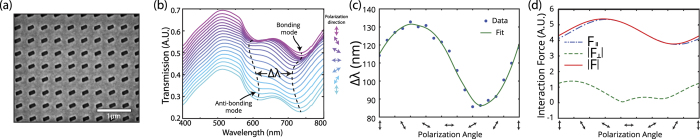
(a) A top-view scanning electron microscope image of the metasurface. (b) The transmission spectra associated with different linear polarization angles, where we observe the presence of bonding and anti-bonding modes. (c) Shift in the wavelengths of the bonding and anti-bonding modes as a function of polarization angle. (d) Interaction forces parallel and perpendicular to the polarization axis experienced by the resonators from Eq. 4 as a function of polarization angle.